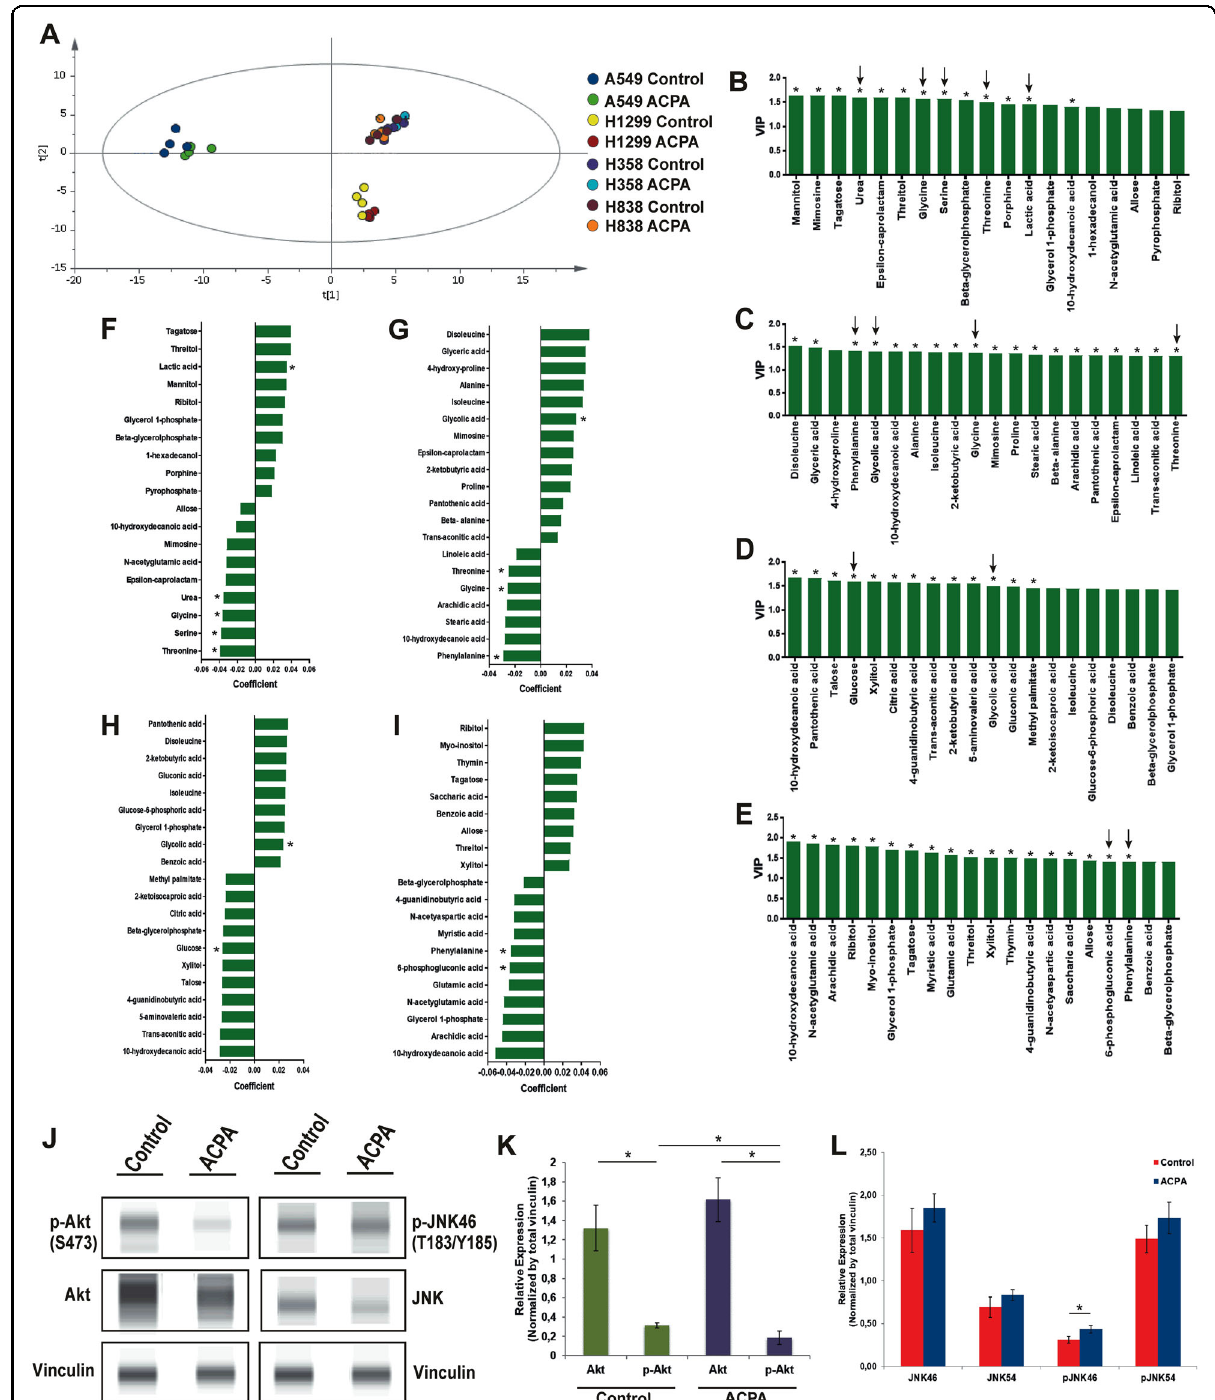
Fig. 4 ACPA inhibits p-Akt, induces p-JNK and affects levels of speci fi c metabolites in NSCLC lines. a Principal component analysis (PCA) score plot: Metabolomics pro fi ling of control and ACPA-treated A549, H1299, H358, and H838 cells. b Changes in variable importance in projection (VIP) values for 19 metabolites in A549 cells. c , d , e Changes in VIP values for 20 metabolites in H1299, H358, and H838 cells. Signi fi cantly changed metabolites (* p < 0.05, indicated by arrows) were matched to apoptotic pathways. f , g , h , i Increase and decrease in several metabolites of ACPA- treated A549, H1299, H358, and H838 cells (* p < 0.05). j Simple Western showing total Akt, p-Akt (S473), total JNK46 and JNK54 and p-JNK46 and p- JNK54 (T183/Y185) in A549 cells at 24 hours after treatment with IC50 dose of ACPA. k Relative expression levels of Akt and p-Akt for control and ACPA-treated A549 cells after normalization by total vinculin protein. l Relative expression levels of JNK (46 and 54 kDa) and p-JNK for control and ACPA-treated A549 cells after normalization by total vinculin protein. * p < 0.05, Student ’ s t-test. All tests were done in